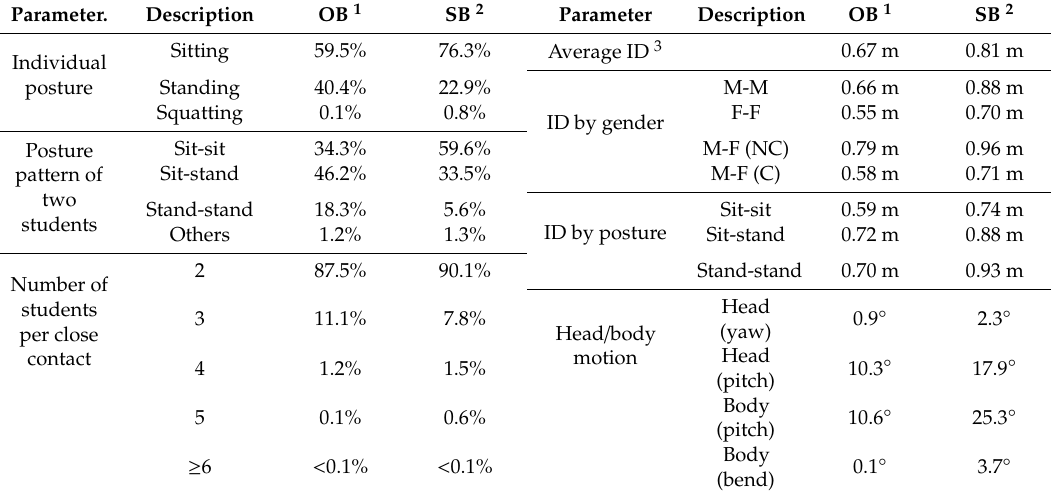
Table 2. Comparison of indoor human behaviors during close contact in a graduate student o ffi ce between the previous observation study and the present sensor-based study.